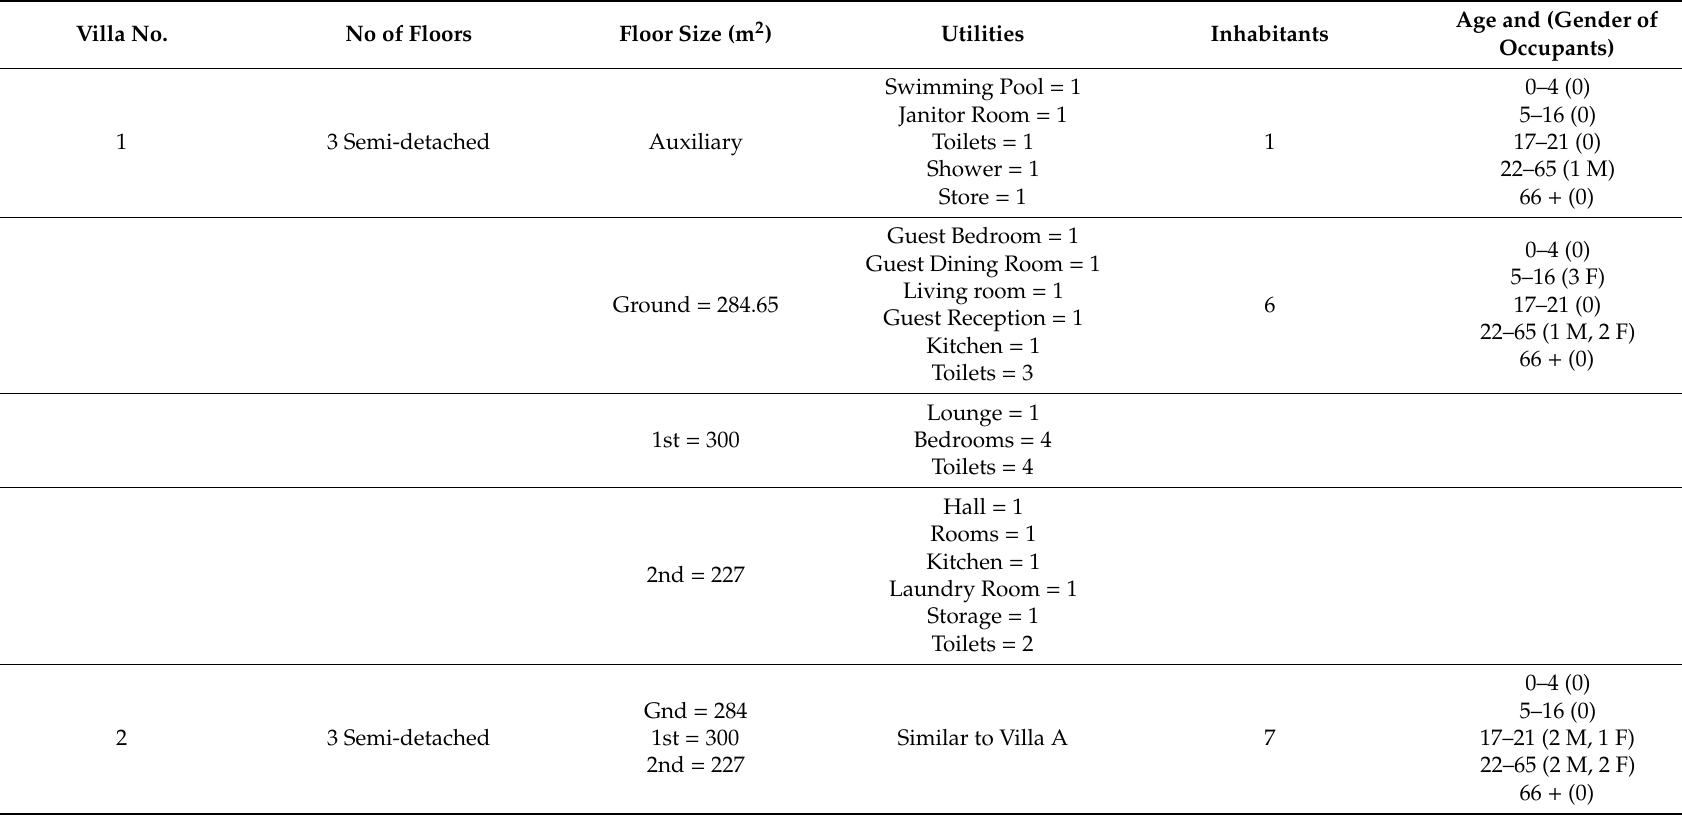
Table 2. The characteristics of the two identical villas, used in the case